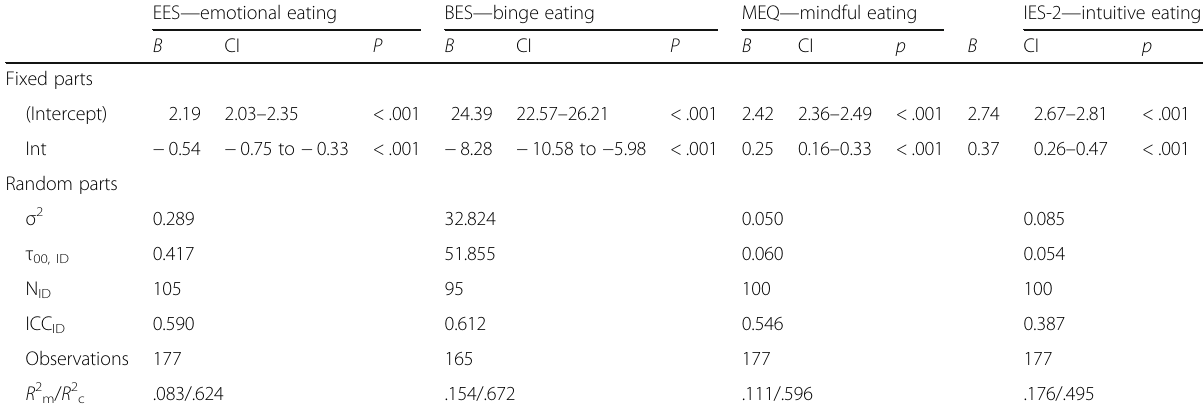
Table 4 Linear mixed-model analysis results for adaptive and problematic eating behaviors EES — emotional eating BES — binge eating MEQ — mindful eating IES-2 — intuitive eating